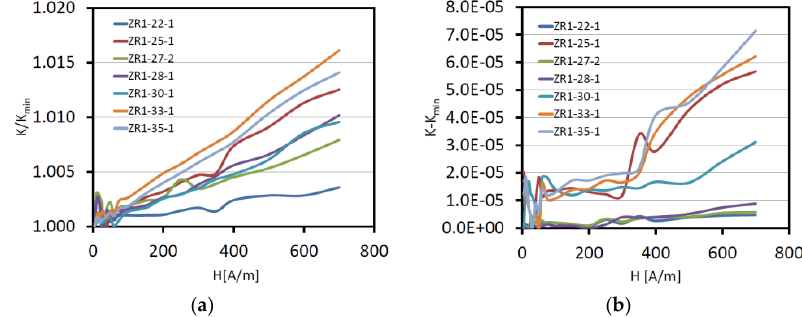
Figure 5. Field variation of in-phase ( a ) and out-of-phase, ( b ) susceptibility in pilot specimens.